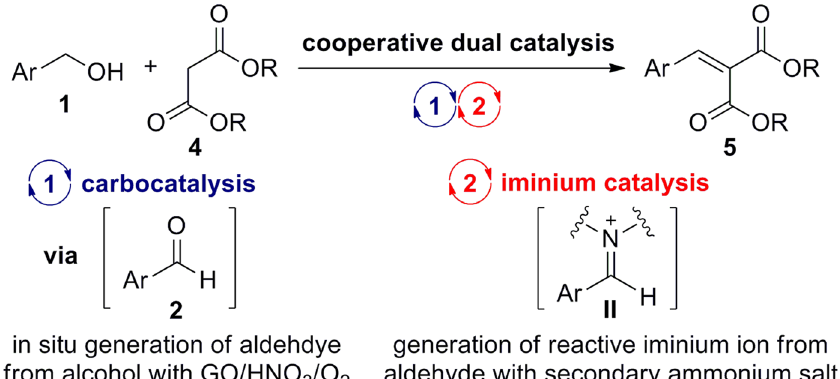
Figure 5. Strategy for a variant of the Knoevenagel condensation via cooperative catalysis.